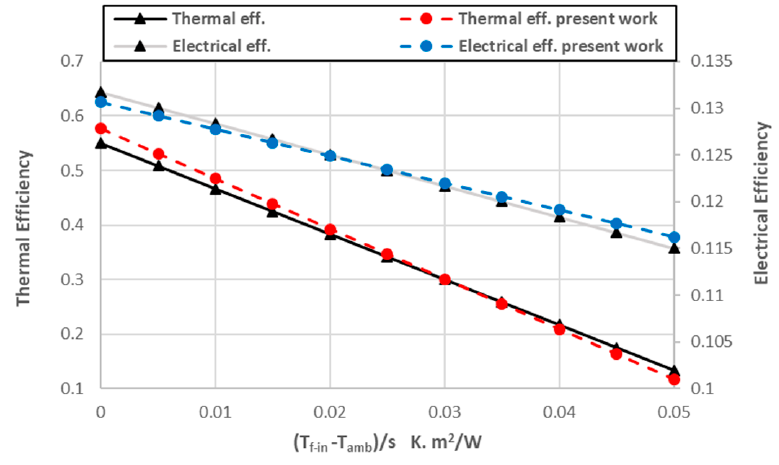
Figure 5. Comparison of the thermal-electrical efficiency of the present work and Vielt [19].